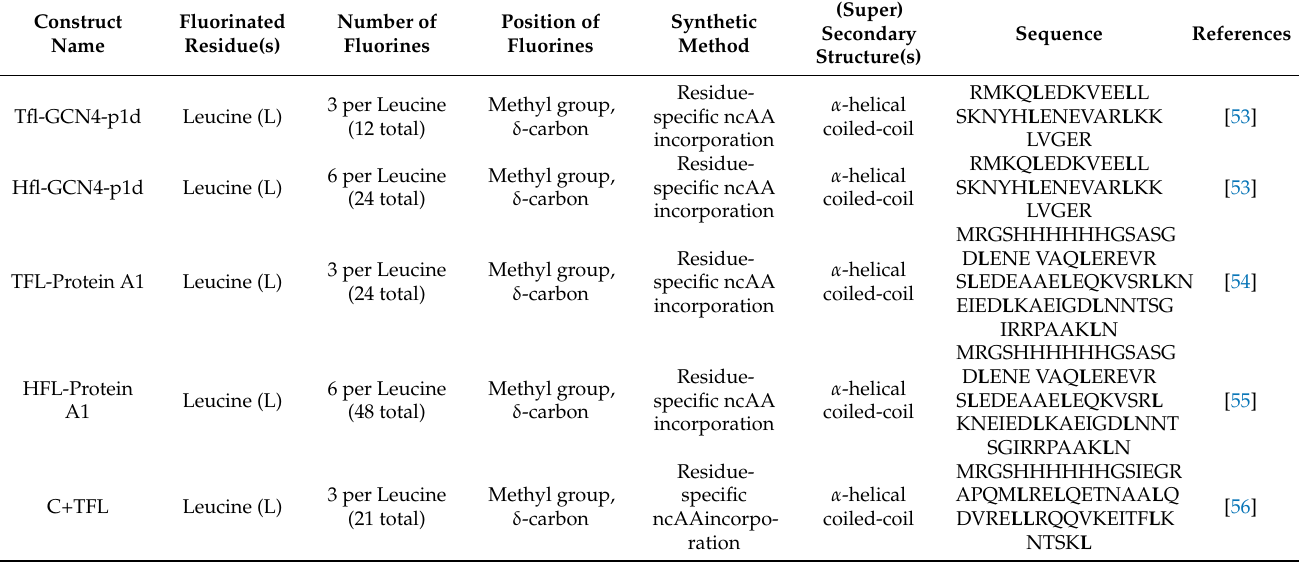
Table 2. Summary of fluorinated proteins and peptides constructs alongside their accompanying one letter AA sequences in the order they are examined to discern the impact of fluorination on higher-ordered supersecondary